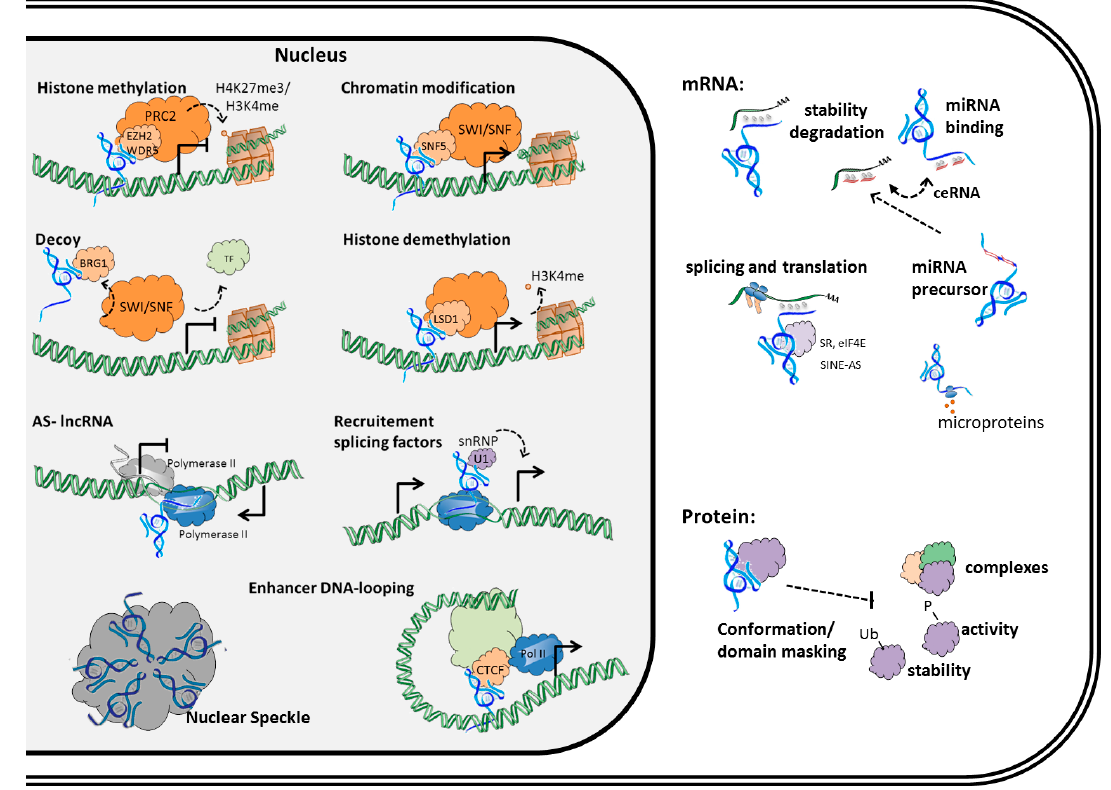
Figure 1. The function of lncRNAs in the cell. LncRNAs exert different functions in the nucleus, ranging from genomic DNA organization in speckle bodies, histone, and DNA methylation and direct transcriptional regulation (Section 2.1). Through their interaction with mRNA and function in miRNA regulation, they affect protein translation (Section 2.2). In addition, they interact with proteins, affecting stability, activity, and/or complex recruitment (Section 2.3).